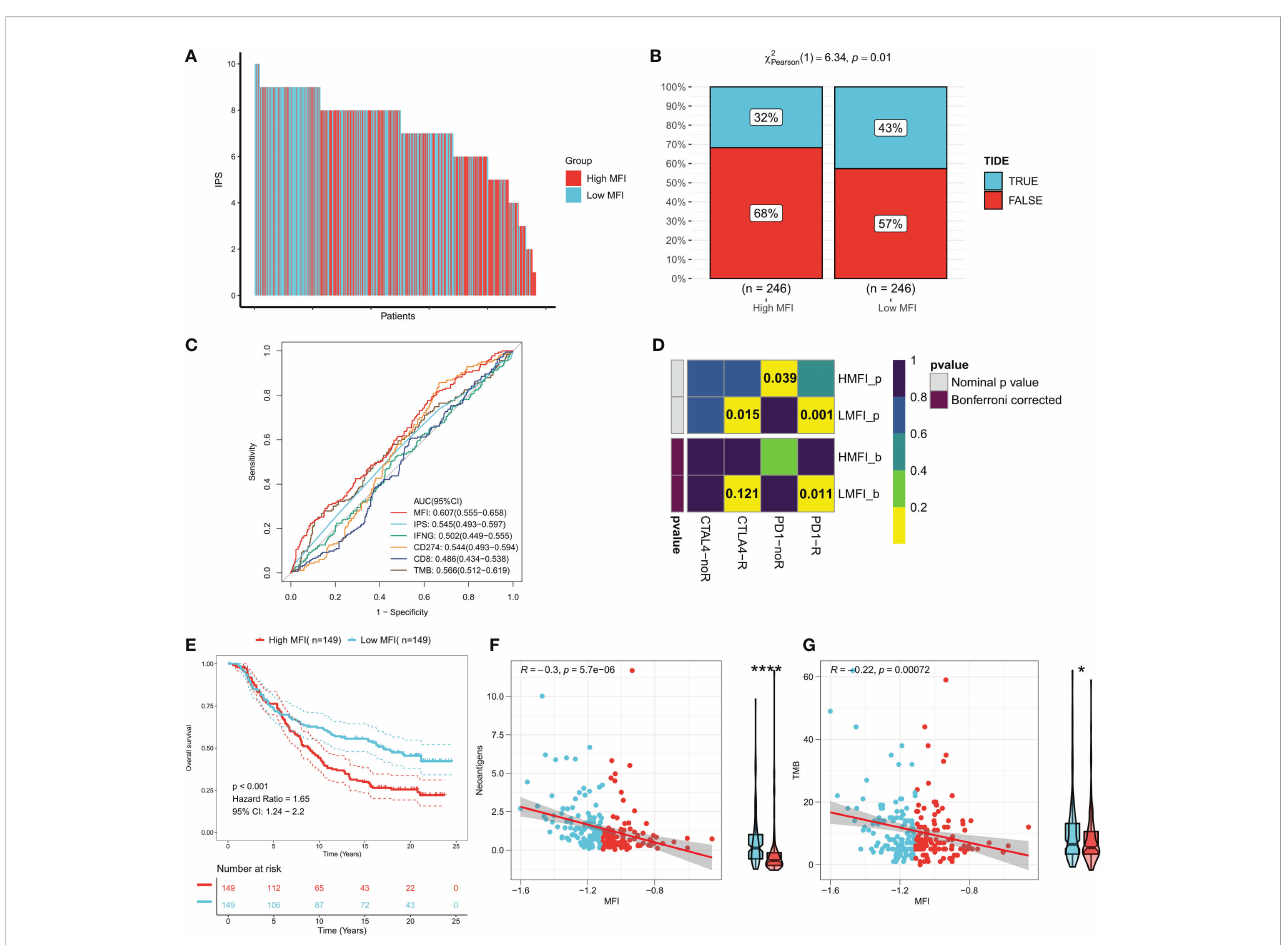
FIGURE 9 Low MFI group is more sensitive to immunotherapy. (A) Differences in IPS between the two subtypes. Low MFI group was characterized with apparently higher IPS; (B) IDE algorithm predicted the immunotherapy response rates in high and low MFI groups, showing that patients with low MFI had higher response rates (p=0.01); (C) ROC curves showed the predictive accuracy of MFI and different immunomarkers. Compared to other assessments, MFI showed a non-negligble advantage (AUC=0.607); (D) Subclassmapping assessed immunotherapy responses from another different perspectives. (E) Survival curves for high and low MFI subgroups in the Imvigor210 cohort. (F) Correlation of MFI with Neoantigens in the Imvigor210 cohort. (G) Correlation between MFI and TMB in the Imvigor210 cohort. *P<0.5,